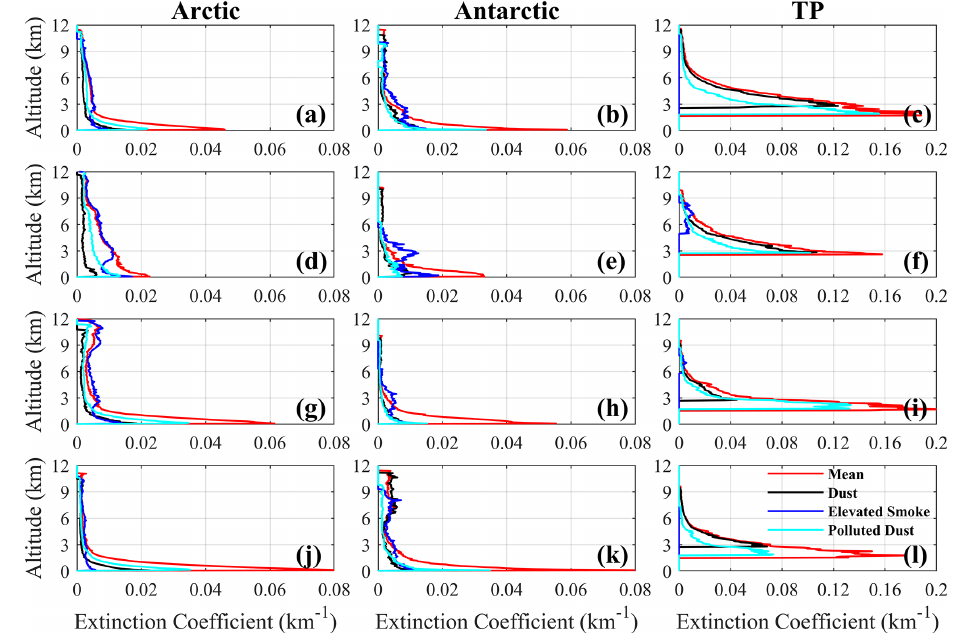
Figure 6. The vertical distribution of seasonally (spring: a–c ; summer: d–f ; autumn: g–i ; winter: j–l ) averaged aerosol extinction coefficient at 532nm during the study period from June 2006 to December 2019 over the Arctic (left panels), Antarctic (middle panels) and TP (right panels), including the mean extinction coefficient (solid red line), dust extinction coefficient (solid black line), elevated-smoke extinction coefficient (solid blue line) and polluted-dust extinction coefficient (solid cyan line) over the Arctic ( a , d , g and j ), Antarctic ( b , e , h and k ) and TP ( c , f , i and l